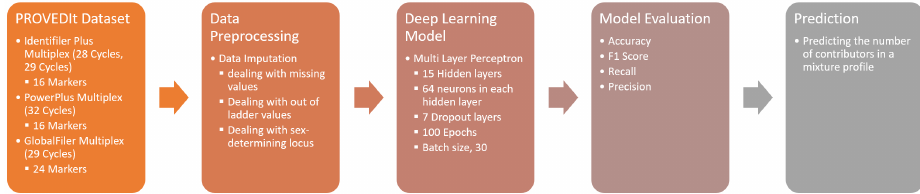
Figure 11. TAWSEEM: a high-level